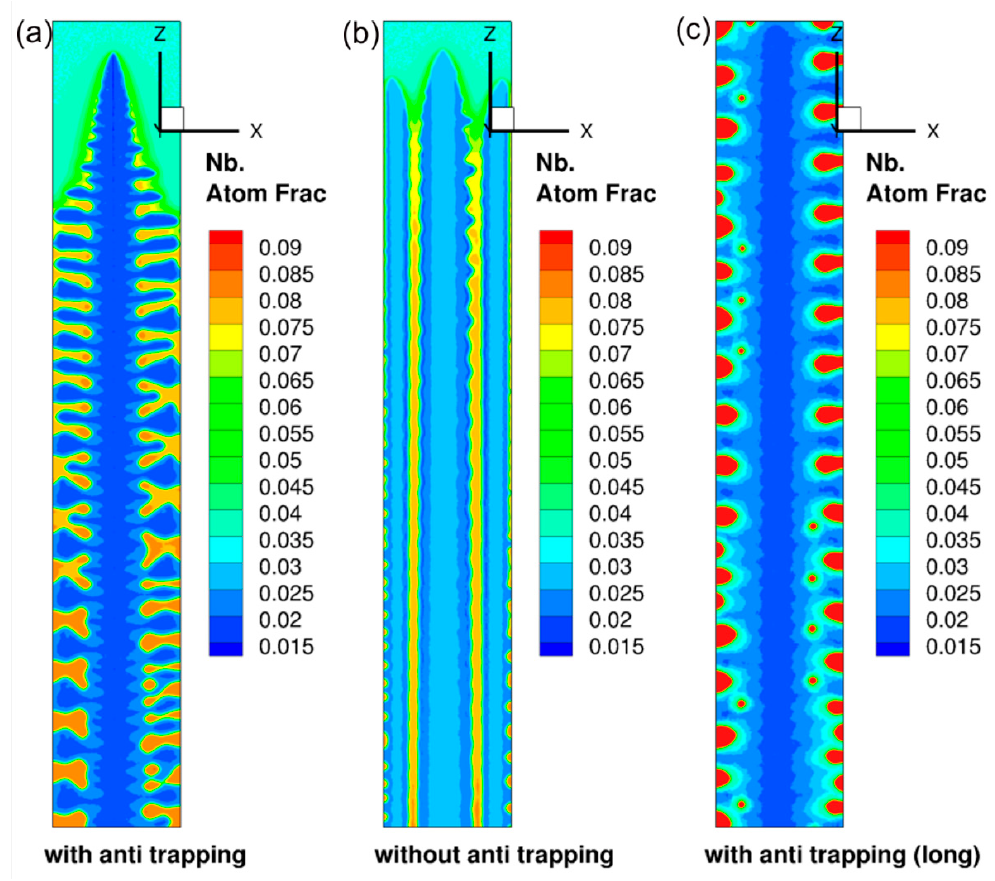
Figure 10. ( a ) Effect of anti-trapping term on Nb partitioning and dendrite morphology during solidification in a temperature gradient of 2.6 × 10 6 K/m and a s-l interface velocity of 0.1 m/s, ( b ) shows the segregation without anti trapping. The microstructure after cooling the domain below the equilibrium solidus of 1537K is shown in ( c ).